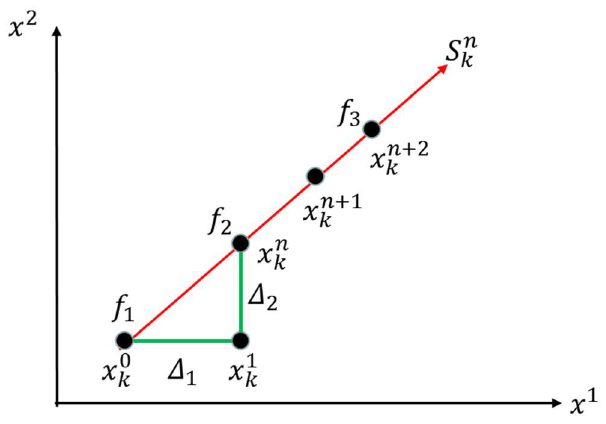
Figure 6. Schematic diagram of parameter description.